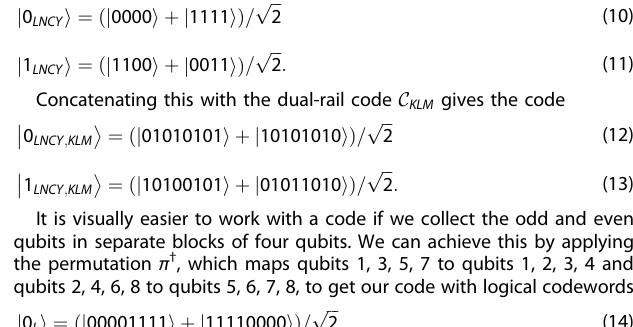
is multiplicative under composition, (1 − ϵ base ) = (1 − δ ) T and